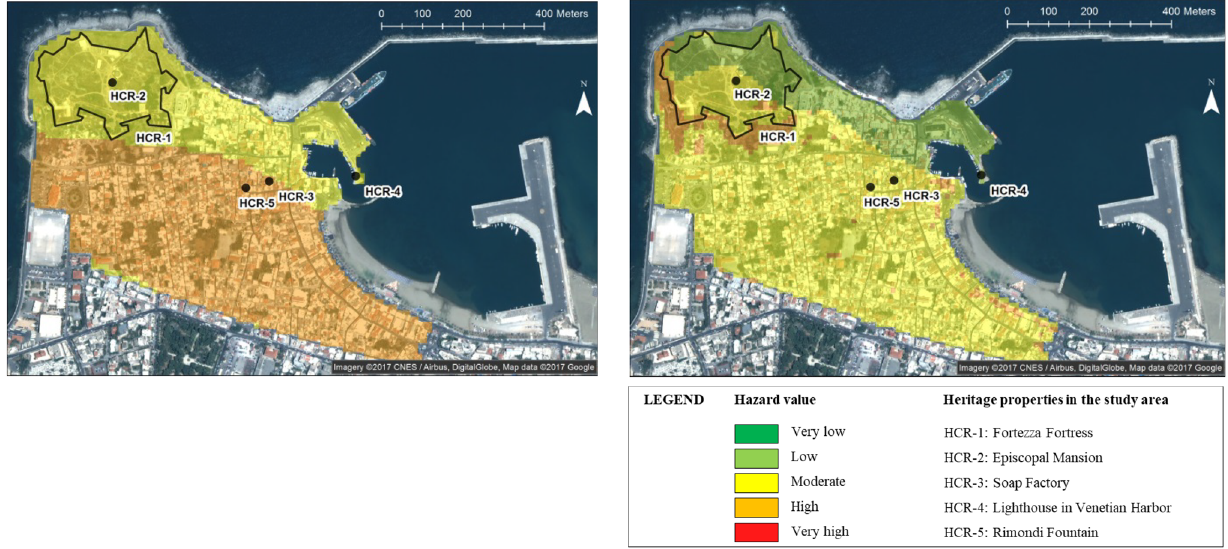
Fig. 5 Left: Earthquake hazard map for the site area in Rethymno, Crete, Greece representing corresponding ground susceptibility; Right: Landslide hazard map for the site area representing corresponding ground